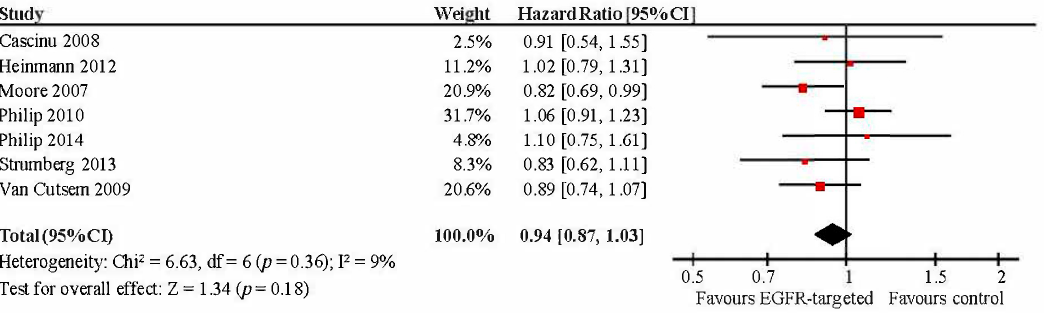
Figure 3. Forest plot showing hazard ratio for overall survival for addition of EGFR-targeted treatment to chemotherapy versus control. Experimental arm: EGFR-targeted therapy + chemotherapy; Control: chemotherapy; CI: confidence interval.